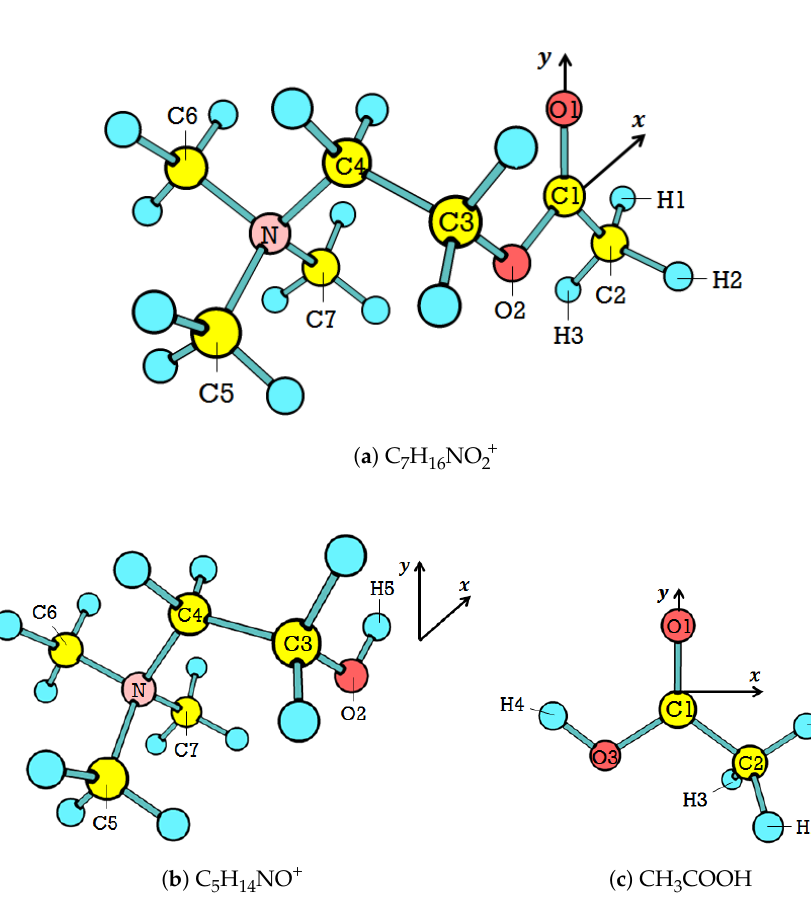
Figure 1. The molecular models of ( a ) ACh + , ( b ) Ch + , and ( c )